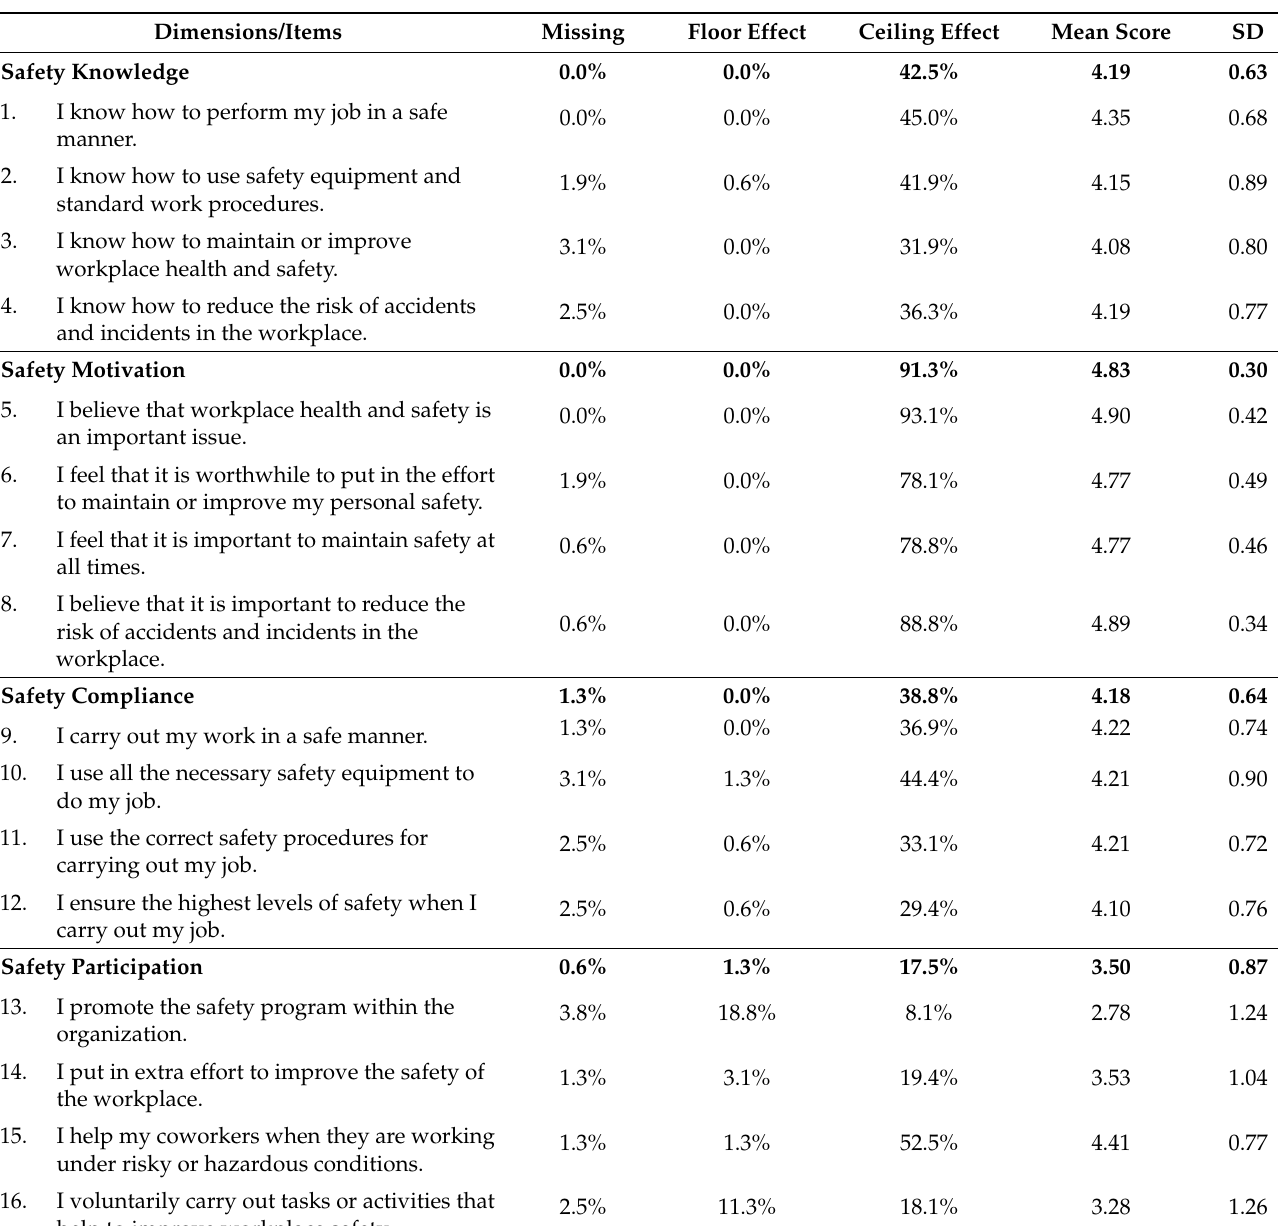
Table 2. Descriptive statistics of the WHASI-G items and scales.